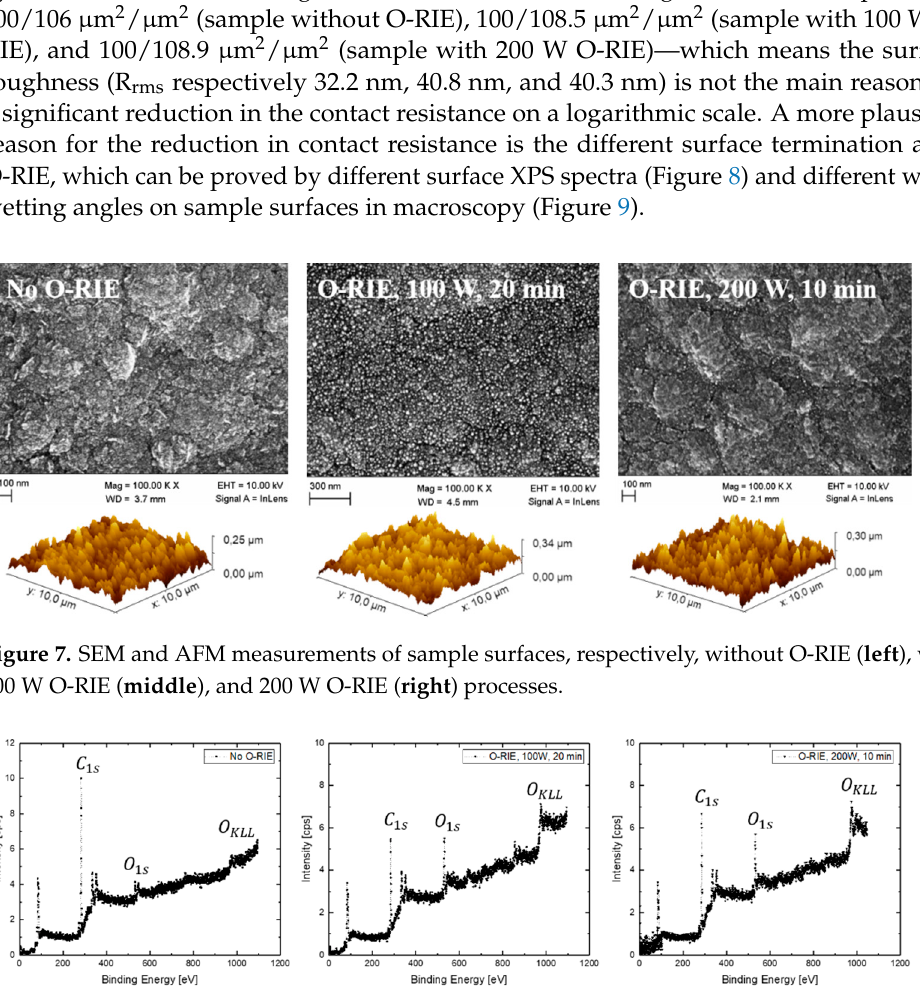
Figure 9. Contact angle measurements, respectively, for sample surfaces without O-RIE (left), with 100 W O-RIE (middle), and 200 W O-RIE (right) processes.